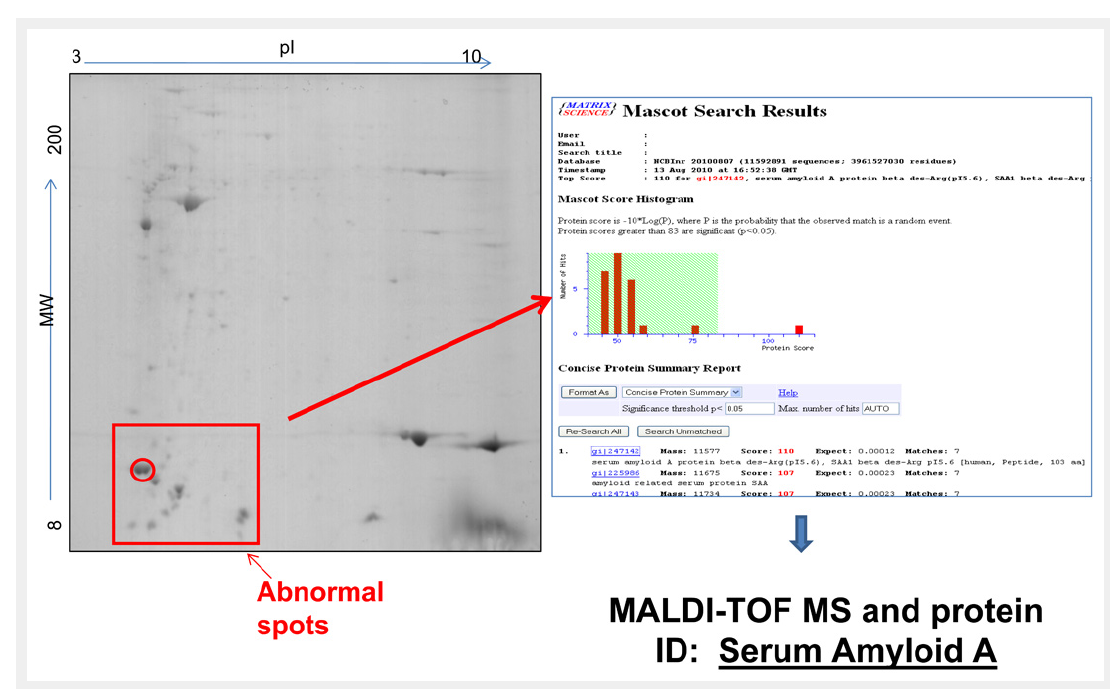
Figure 1 Typical 2D-PAGE map of fat tissue in AA amyloidosis. A 73-year old man presented with signs of renal and gastrointestinal amyloidosis. Immunohistochemistry classified the disease as ALκ type. However, due to the absence of a serum or urine monoclonal component, with normal serum free kappa light chains and κ/λ ratio, this result was considered inconclusive. Proteomic analysis by means of two-dimensional polyacrylamide gel electrophoresis (2D-PAGE, left panel) showed the presence of abnormal spots (in the box) that are not found in controls. Mass spectrometry analysis of excised spots, followed by data base search (right panel) characterized these spots as N-terminal fragments of SAA, allowing definite typing of